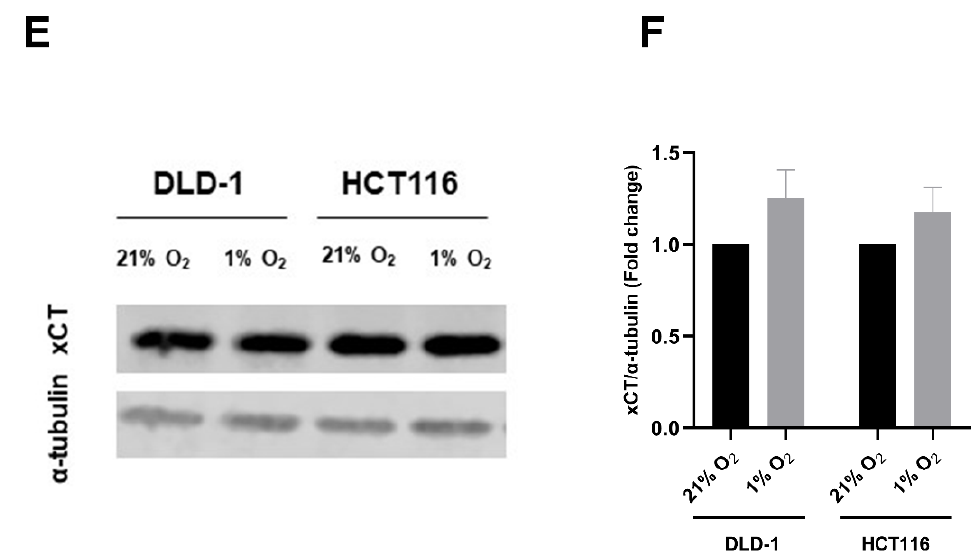
Figure 1. SLC7A11 /xCT is overexpressed in human colorectal cancer. ( A ) SLC7A11 mRNA expression level in microsatellite instable (MSI) CRC patients vs. microsatellite stable (MSS) CRC patients. Correlation of SLC7A11 expression with the ( B ) Buffa hypoxia score, ( C ) Winter hypoxia score, and ( D ) the Ragnum hypoxia score. ( E ) Representative blot showing the expression levels of xCT in DLD-1 and HCT116 cell lines under normoxic (21%) and hypoxic (1%) conditions, using alpha-tubulin as the reference gene. ( F ) Summarizing graph showing the quantitative values of the western blot. Data are shown as mean ± SEM, n > 3. An unpaired t -test was used in the case of a normal distribution (panel ( A )), while a Mann Whitney test was used if normality was not present (panels ( B – D )), or a two-way ANOVA followed by Bonferroni’s test (panel ( F )) was used for statistical analyses. ** p < 0.01, *** p < 0.001, **** p < 0.0001. The uncropped blots are shown in Figure